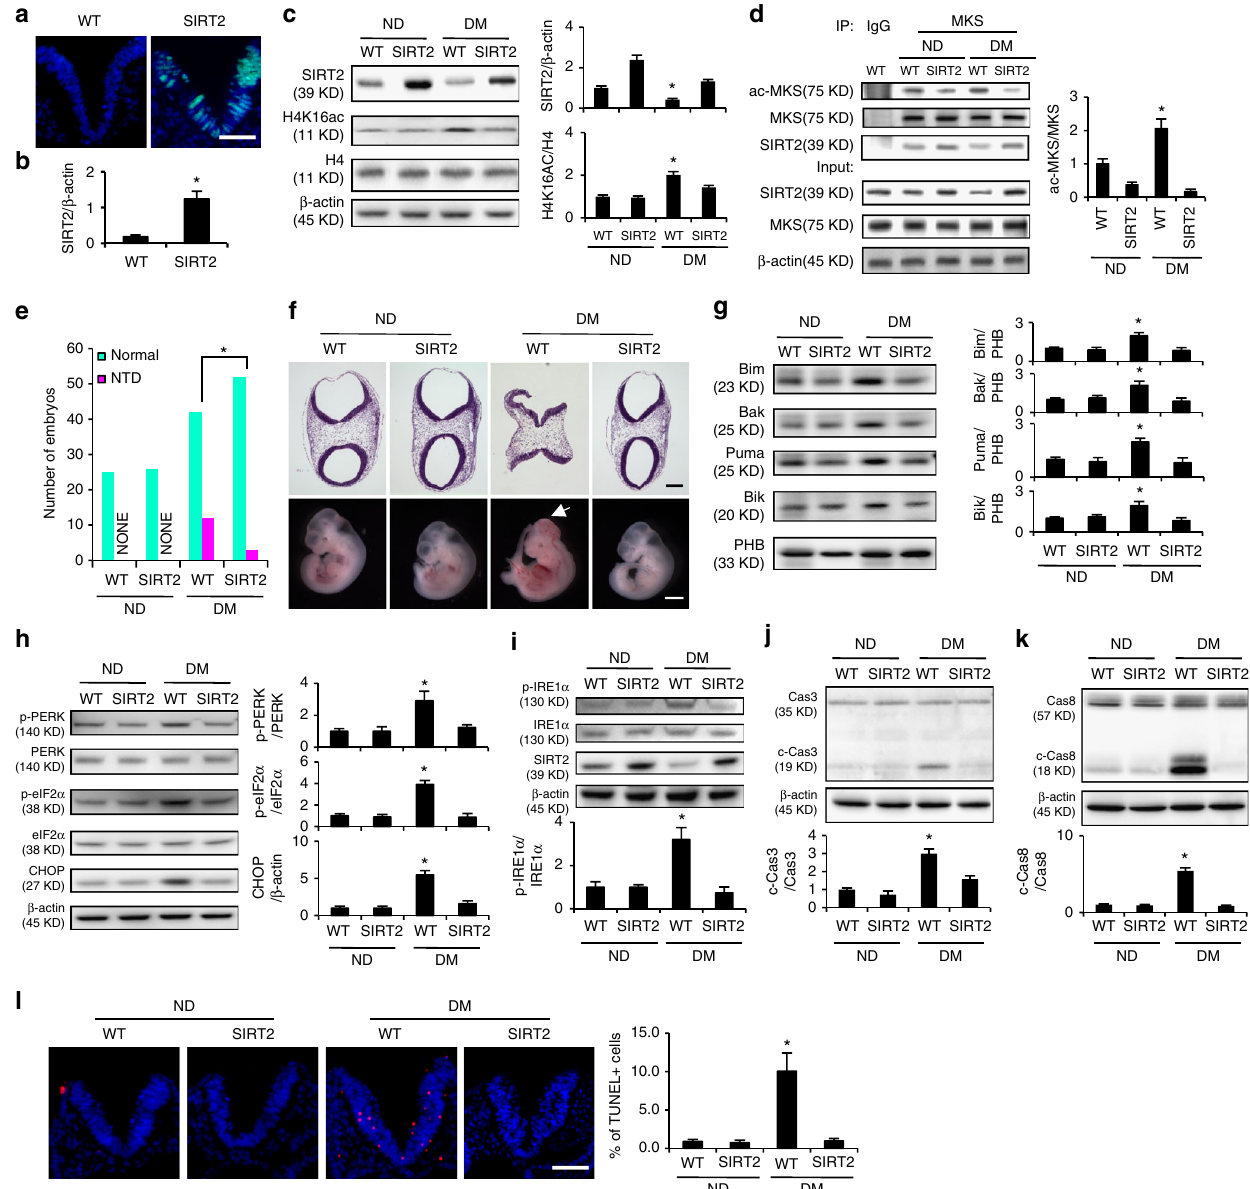
Fig. 7 SIRT2 overexpression attenuates maternal diabetes-induced neuroepithelial cell apoptosis and ER stress. a SIRT2 overexpression (green signals) was observed only in the neuroepithelia of transgenic embryos. Bar indicates 70 μ M. b mRNA abundance of SIRT2 in transgenic embryos. * Indicates signi fi cant difference ( P < 0.05) in a t test. c Protein abundance of SIRT2 in transgenic embryos. d Abundance of MARCKS acetylation. e Numbers of normal and neural tube defect (NTD) embryos. Sample sizes were shown in Supplementary Table 4. f Closed or open neural tubes (white arrow) in normal and NTD embryos. Bar in upper and lower panel indicates 600 μ m and 1 mm respectively. g Mitochondrial abundance of Bim, Bak, Puma and Bik in SIRT2 transgenic embryos. h , i Abundance of p-PERK, p-eIF2 α , CHOP, and IRE1 α in SIRT2 transgenic embryos. j , k Abundance of cleaved caspase 3 and 8 in SIRT2 transgenic embryos. l Apoptotic cells labeled as red in embryonic neuroepithelia. Bar indicates 70 μ m. ND nondiabetic, DM diabetes mellitus, WT wild type, Cas3 caspase 3, c-Cas3 cleaved caspase 3, Cas8 caspase 8, c-Cas8 cleaved caspase 8. All experiments were repeated three times. Three embryos from three different dams ( N = 3) were performed in panel c , d , g , h , i , j and k . One way ANOVA with the Tukey test was used to analyze the data. * Indicates signi fi cant difference ( P < 0.05) compared to the other group or groups